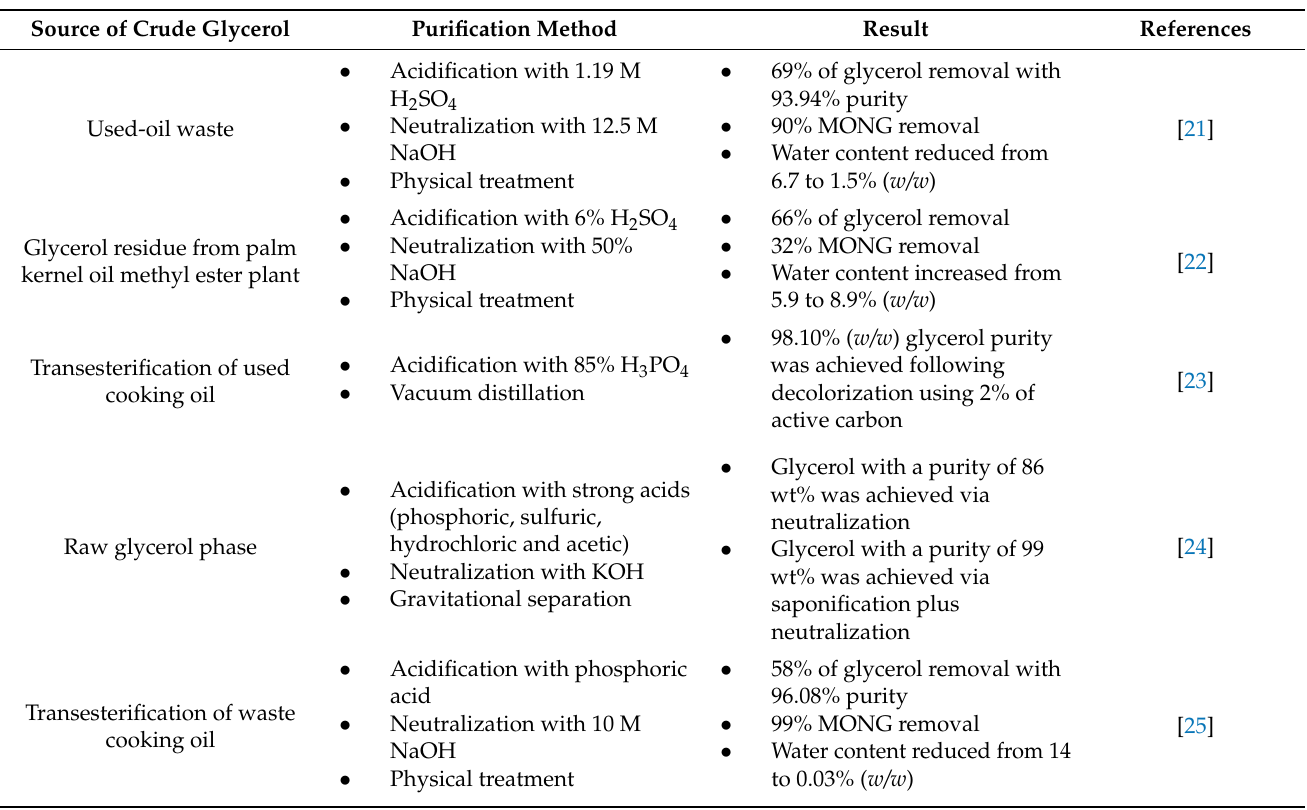
Table 1. Comparison between physicochemical treatments of crude